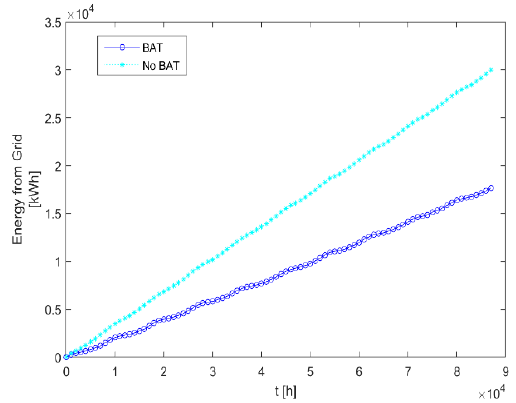
Figure 12. Energy request from the grid (Location 1).